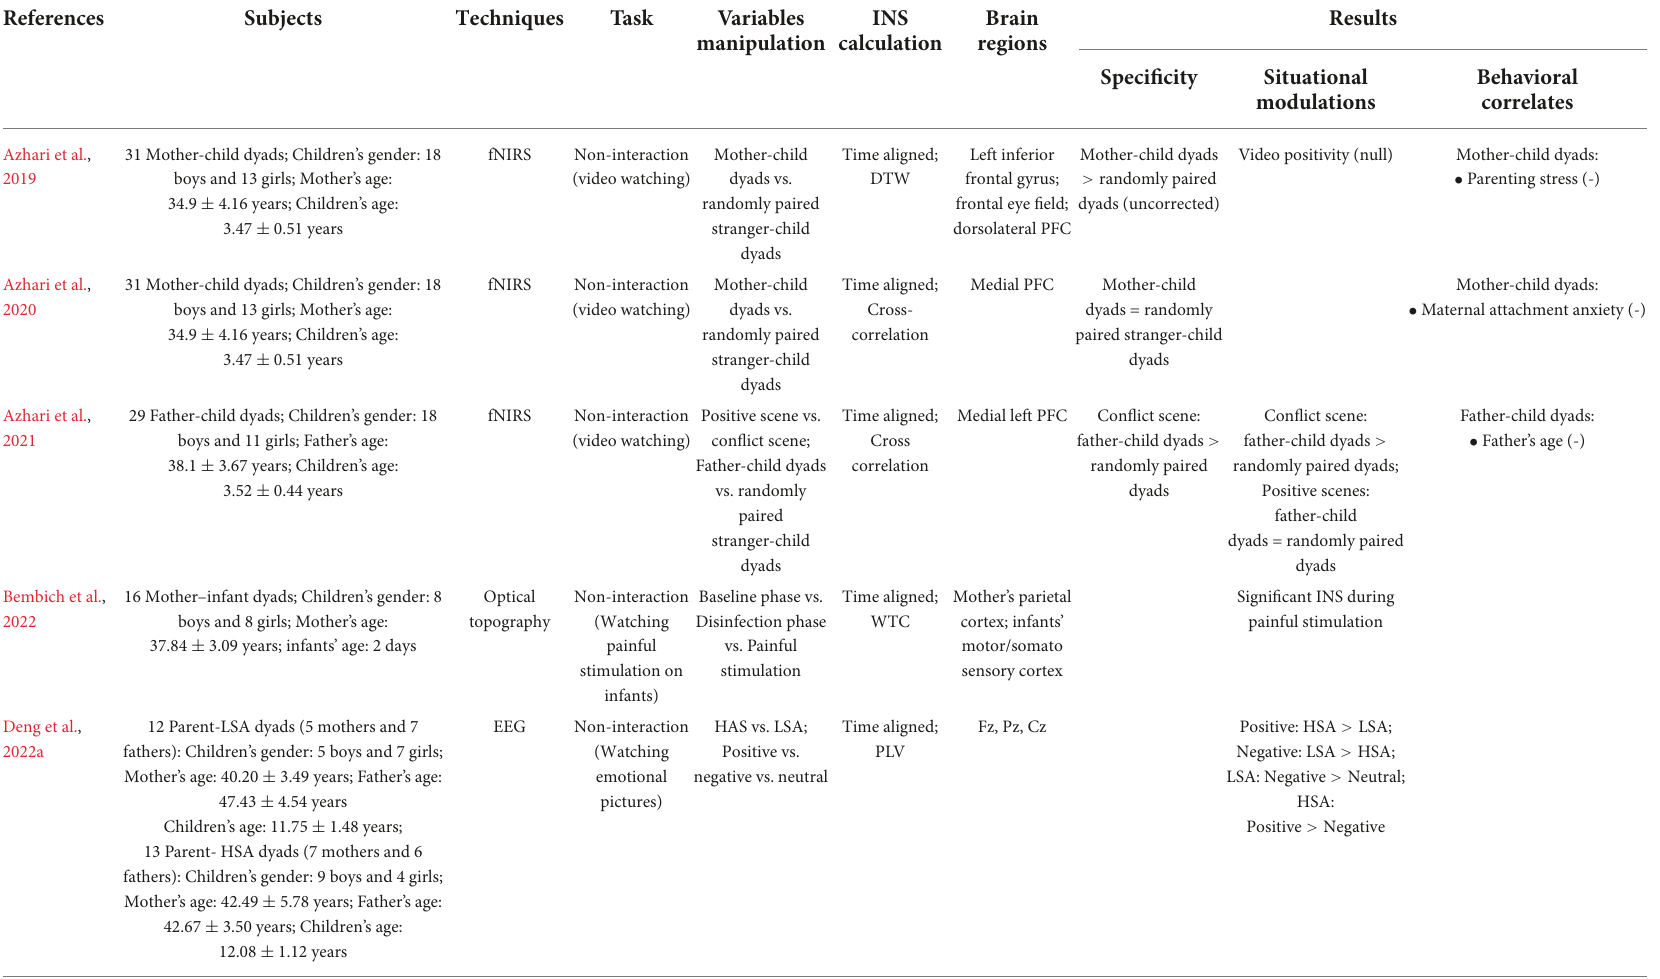
TABLE 1 Summary of the literatures about parent-child neural